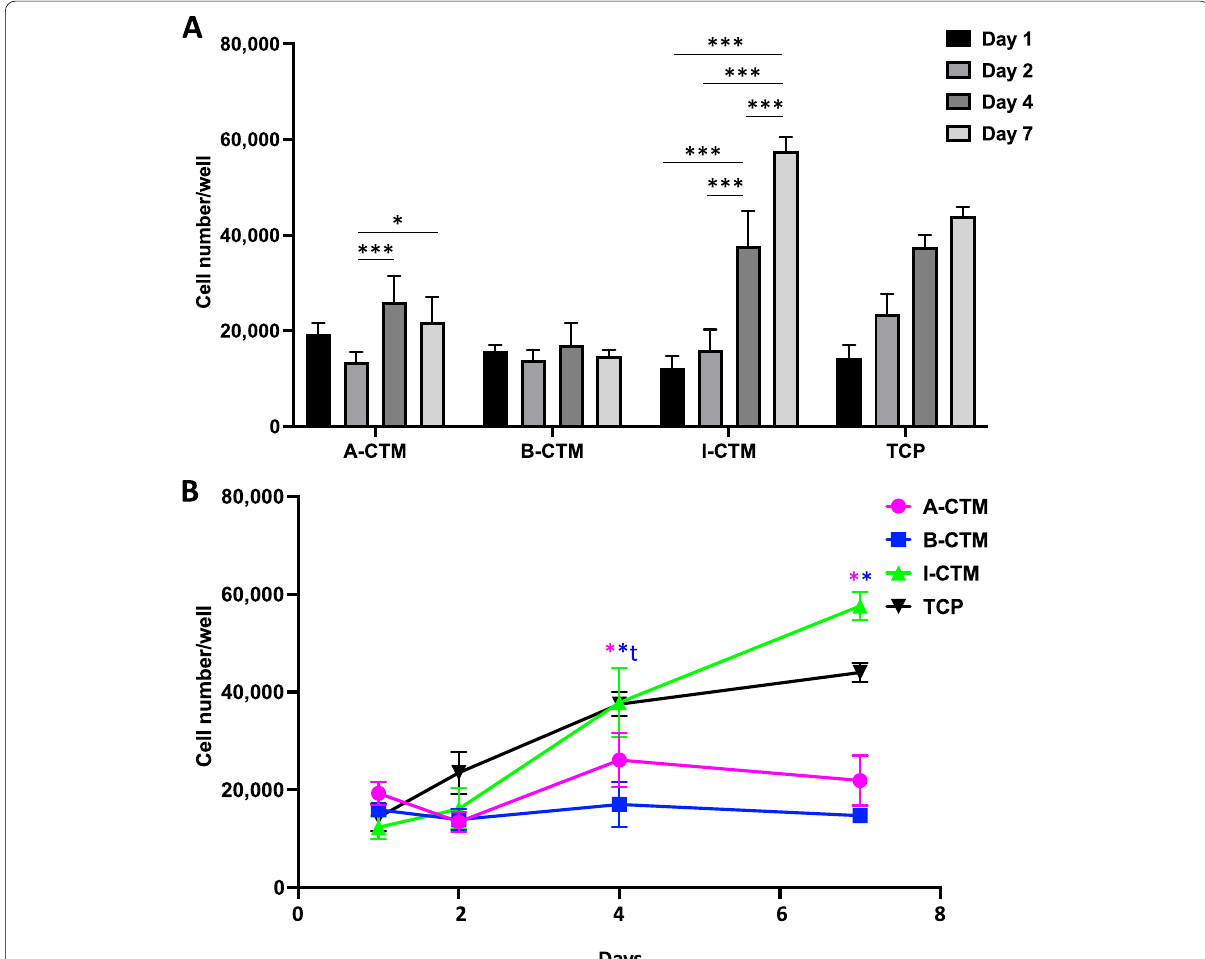
Fig. 2 Proliferation of tenocytes on connective tissue matrices over 7 days. The viabilities of cells were measured by alamarBlue assay on Day 1, Day 2, Day 4, and Day 7 and converted to cell number, using a standard curve. The proliferation of tenocytes is compared over time for each CTM ( A ) and compared between CTMs at each time point ( B ). Data shown are mean indicates comparator and corresponds with legend. t p